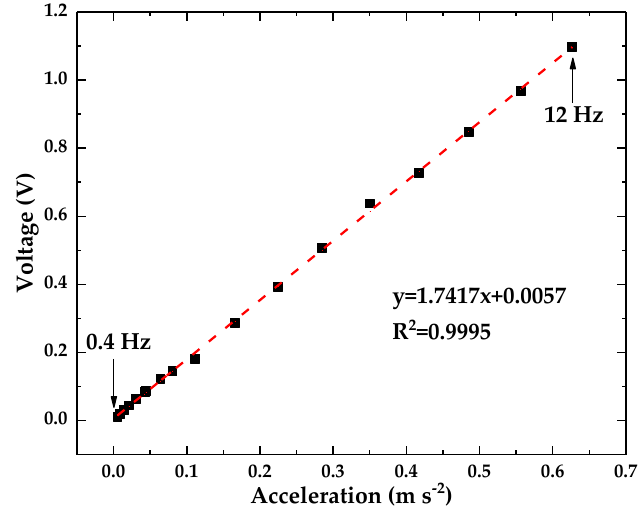
Figure 10. Frequency response range of the optical accelerometer.